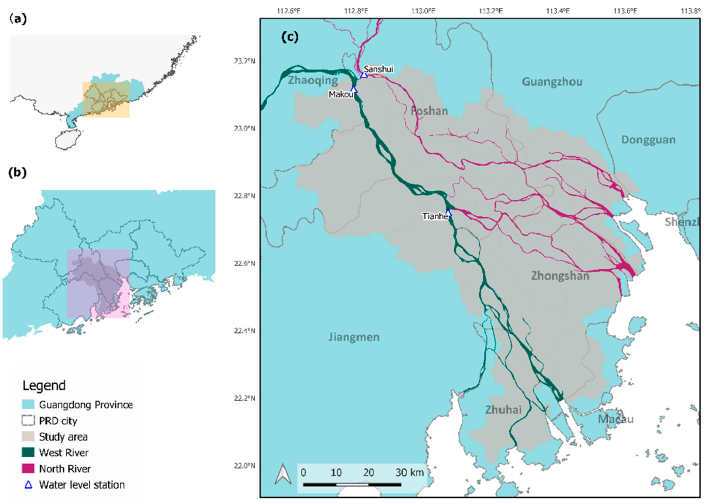
Figure 1. Location of the study area. ( a ) Southern part of China, ( b ) Guangdong province and Pearl River Delta (PRD) cities, and ( c ) study area (shaded in grey) as located primarily in the Foshan-Zhongshan region around the West and North Rivers. The rivers enter into the study area via the Makou and Sanshui gage